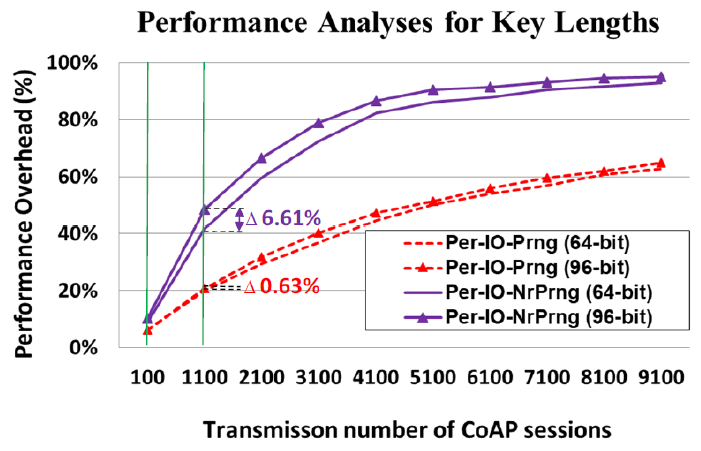
Figure 16. Performance analyses for 96-bit key compared with 64-bit key.